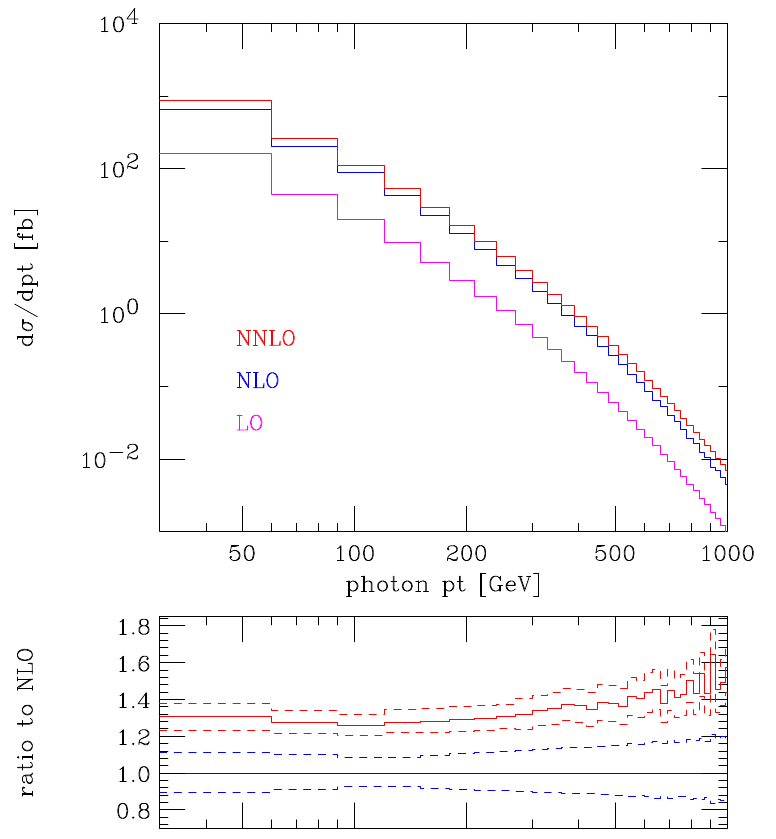
distribution at 13 TeV. The lower panel displays the ratio of the NLO and NNLO pre- Figure 9 . p γ T dictions, including error estimates obtained via a 9-point scale variation, to the central NLO